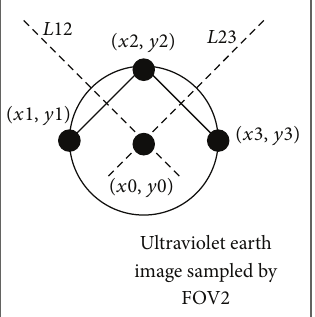
Figure 5: The ring image of ultraviolet earth.